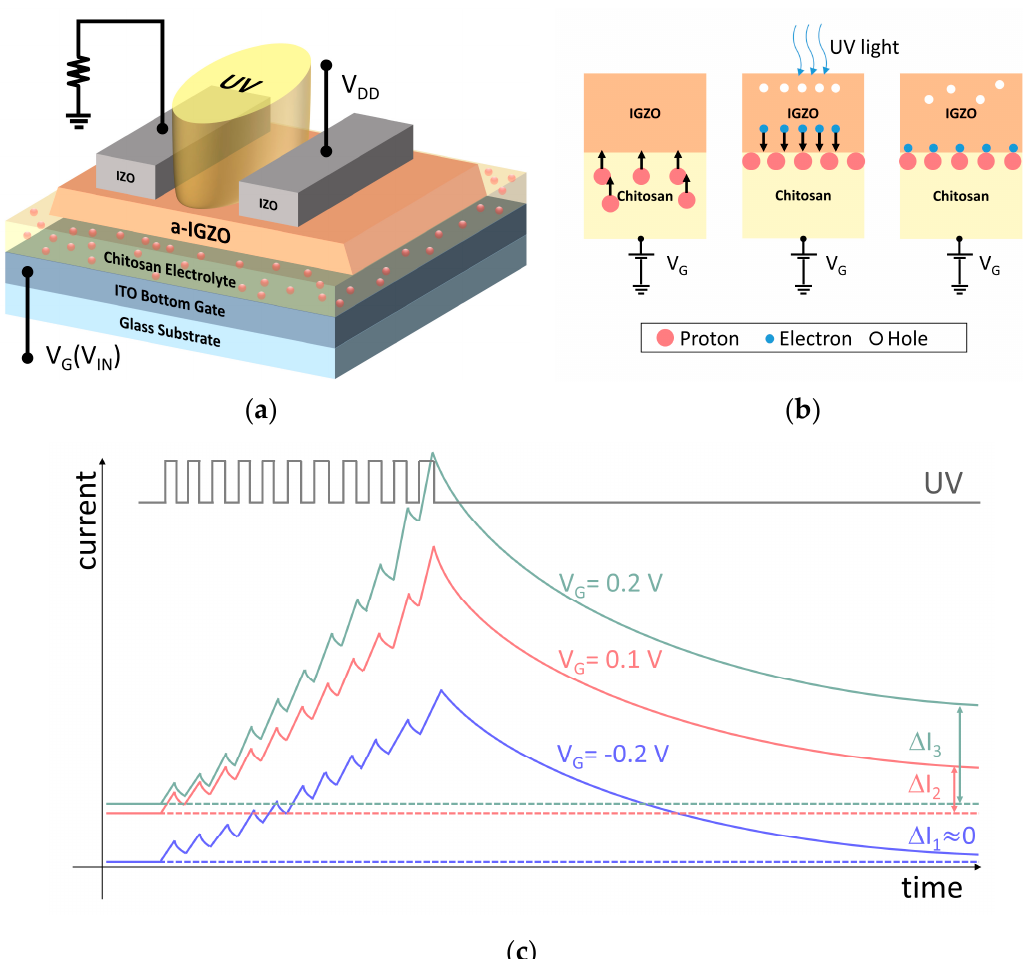
Figure 8. ( a ) Device structure and operating circuit. ( b ) Conceptual diagram of proton migration under gate bias and UV light illumination. ( c ) Experimental result from the device operating under different gate biases. The current differences Δ I 1 , Δ I 2 , and Δ I 3 mimic the variation of synaptic weight depending on the gate bias (redrawn and adopted from [28]).